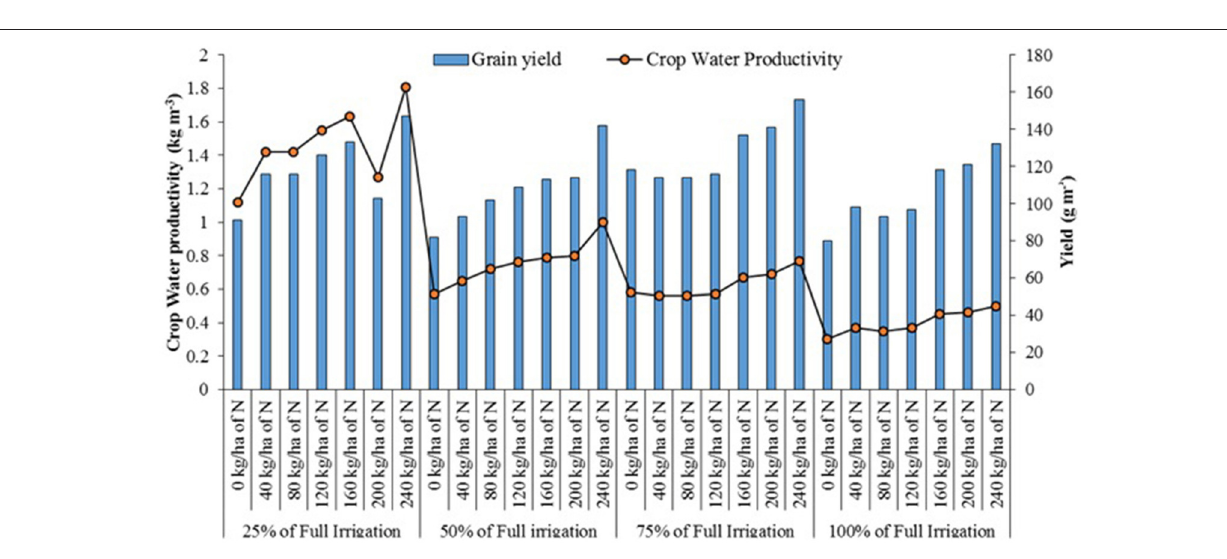
FIGURE 6 | Combined effect of water stress and N fertilization on quinoa yield and water productivity (Hirich,